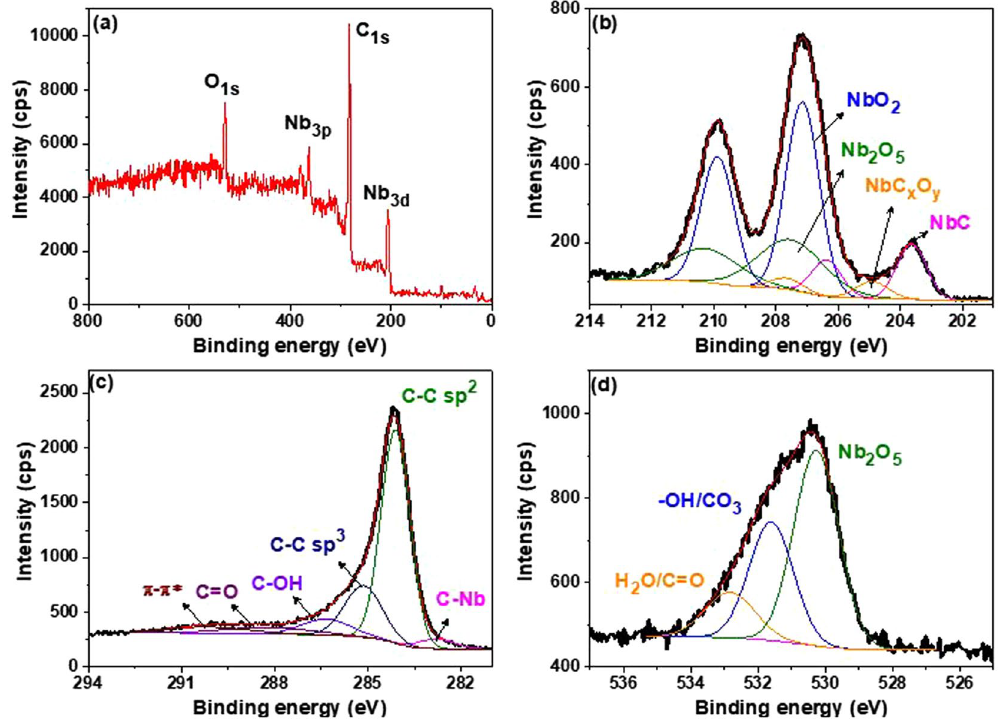
Figure 2. XPS spectra of sample 10C800: ( a ) survey; ( b ) HR-XPS of Nb 3d; ( c ) HR-XPS of C 1 s and ( d ) HR- XPS of O 1 s.